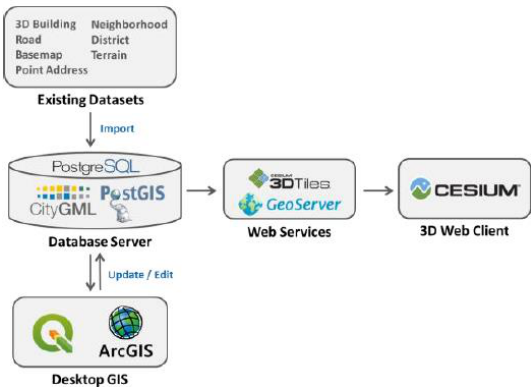
Figure 10: An integrated schematic diagram of the data